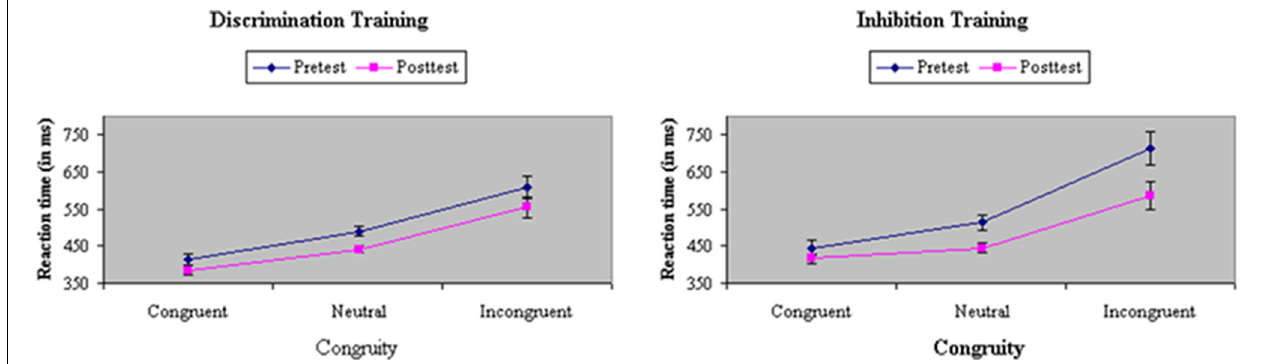
FIGURE 5 | Reaction time (in ms) on congruent, neutral, and incongruent trials in the filtering task at pretest and posttest in discrimination and inhibition training groups. Inhibition training was effective in reducing distraction from incongruent flankers, yielding a significant Train × Congruity × Test interaction.